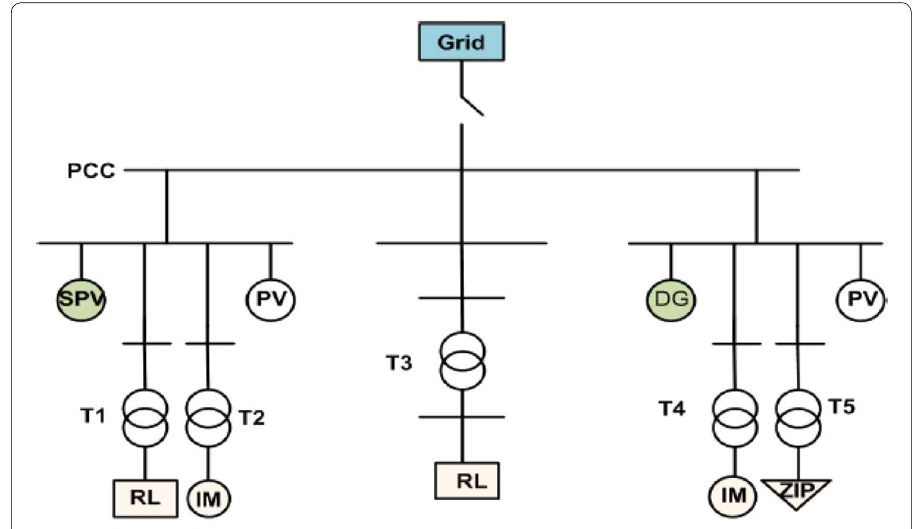
Fig. 3 Microgrid system